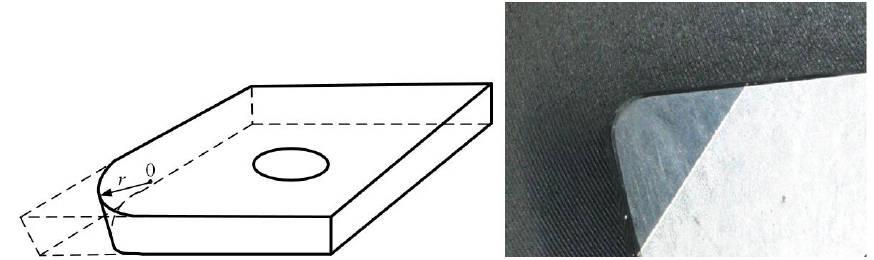
Figure 1. Contrast Diagram of Tool Tip Model with Corner Radius and Ideal Tool